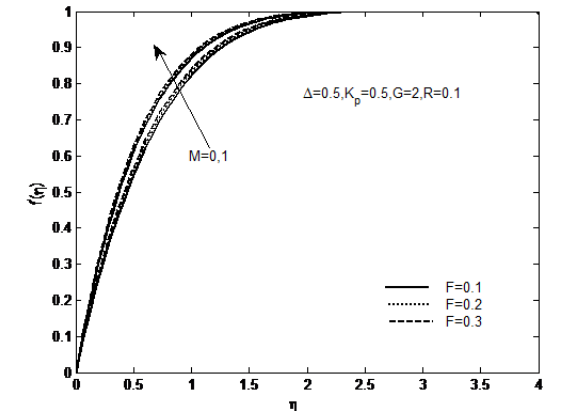
Fig. 4: Velocity profile for different values of M and F